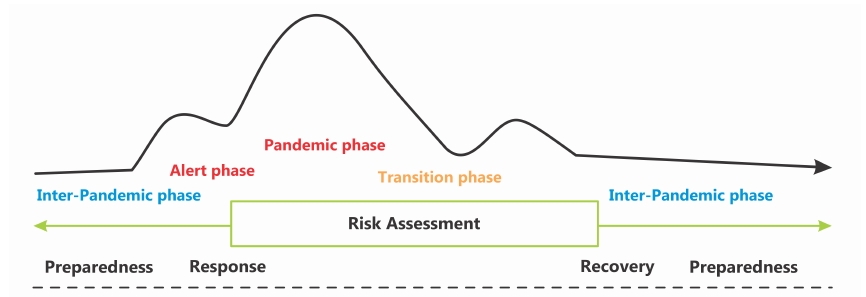
Figure 2. Continuum of pandemic